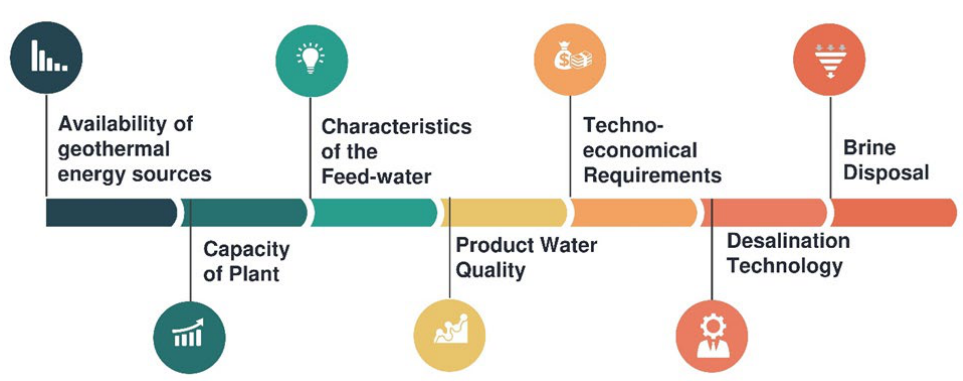
Figure 7. The important parameters in Geothermal Desalination.